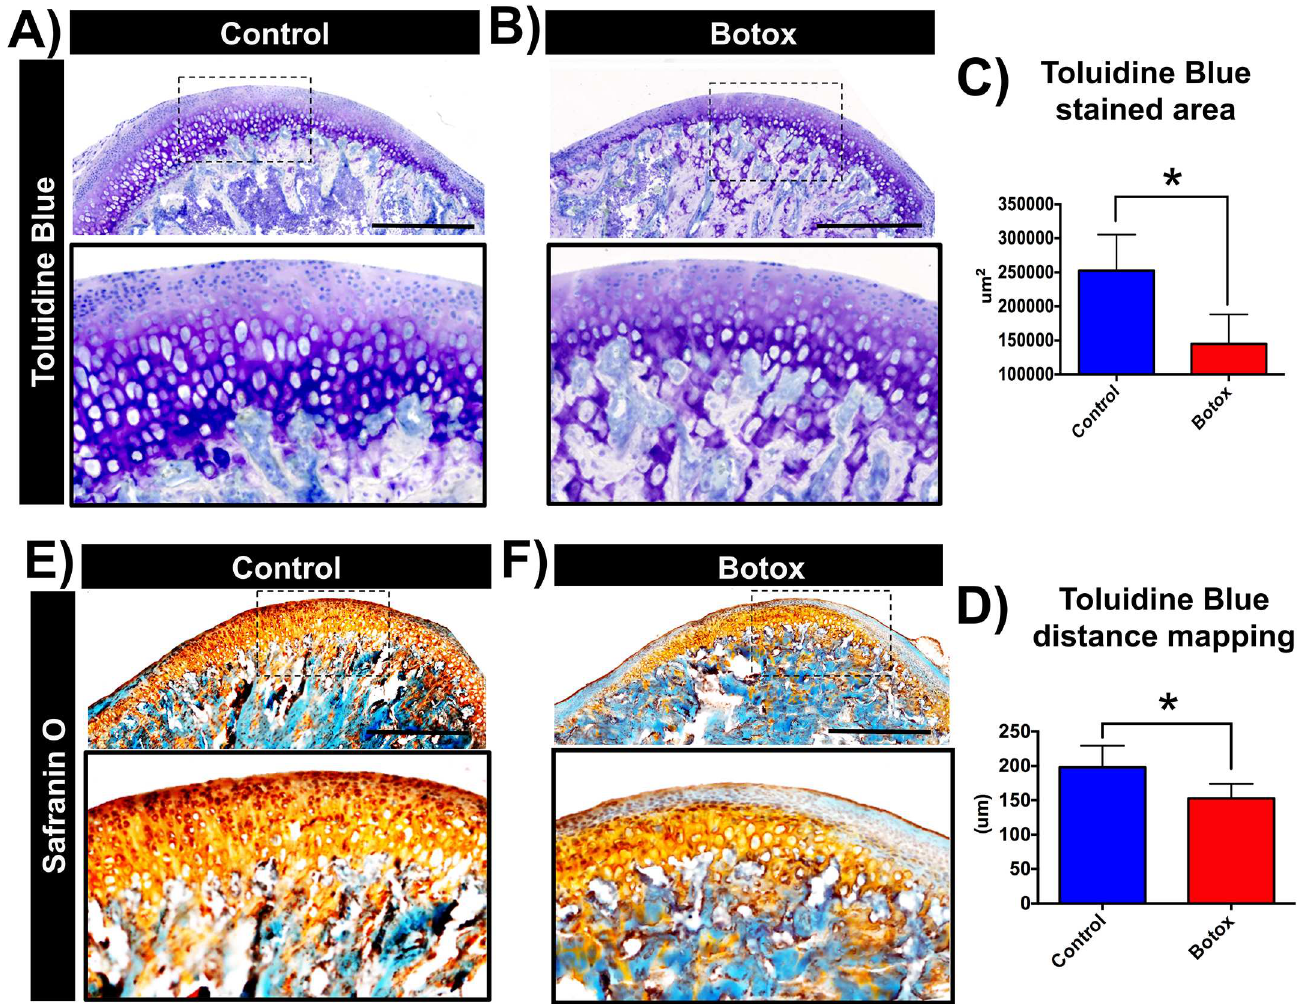
Fig 4. Reduced proteoglycan secretion at the Botox injected side MCC. Sagittal sections of control (A) and Botox (B) injected side condyles stained for toluidineblue. C-F) Quantification of toluidineblue stained area and distance mapping at the MCC. Safranin O staining for control (E) and Botox injected side condyles (F) . Histograms (C-D) represent means ± SD for n = 7 per group . * Significant difference between control and Botox injected side (p < 0.05). Scale bar = 500 μ